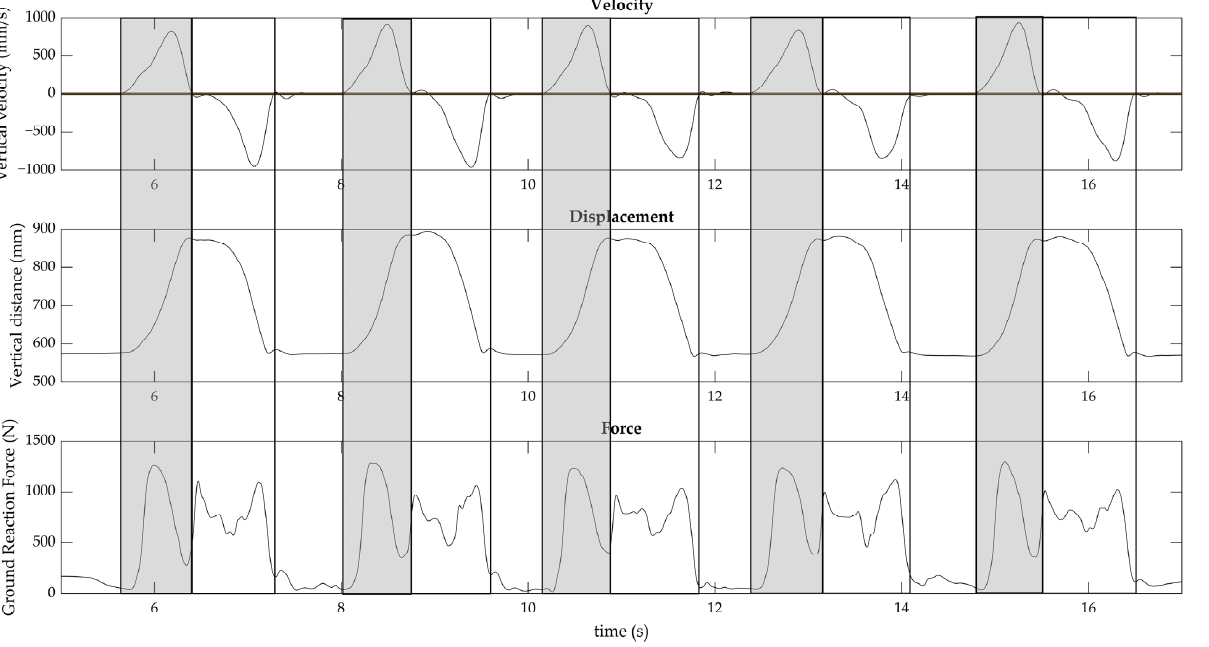
Figure 3. Sample data from a representative subject. Trochanter vertical velocity (the horizontal line identifies the null velocity axes), trochanter vertical distance (displacement), and ground reaction force on z -axes as a function of time. The grey rectangles identify the concentric portion of the movement (i.e., the standing phase). The white rectangles identify the eccentric portion of the movement (i.e., the sitting phase).